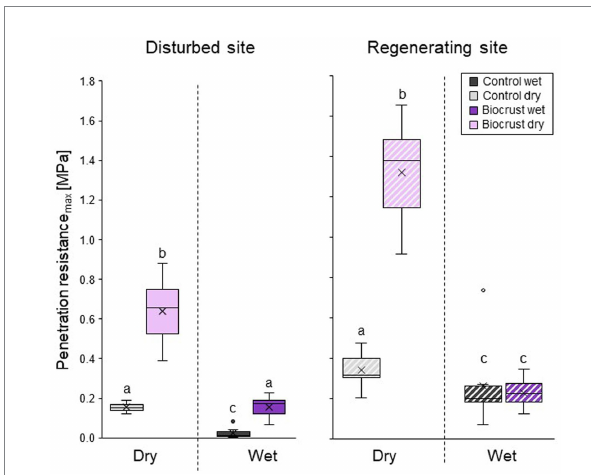
FIGURE 3 Mean maximum penetration resistance of biocrusts (purple) and bare soil patches (control, grey), in disturbed (filled in boxes) and regenerating (striped boxes) Caatinga dry forest, NE Brazil. Penetration resistance was measured under field dry and wet (water content 0.10 m 3 m − 3 ) soil conditions. Boxes represent the interquartile distance between the first and third quartile, the horizontal line the median, the cross the statistical mean, and the antennas the next closest point from an outlier within the data. n = 10 for disturbed and n = 8 for regenerating site for biocrusts and control each. Lowercase letters indicate statistical differences between all measurement conditions per site.